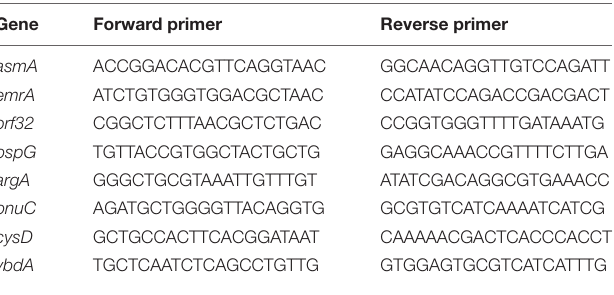
TABLE 1 | Sequences of primers used for